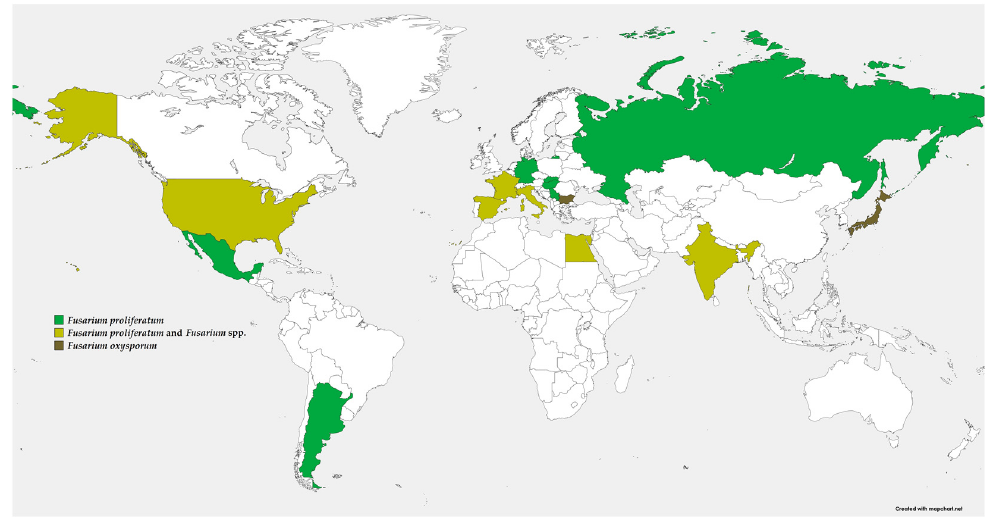
Figure 1. Spatial distribution of dry rot on garlic caused by Fusarium spp. around the world. On the map, green, mustard, and brown color denote F. proliferatum ; F. proliferatum and Fusarium spp.; and F. oxysporum , respectively.